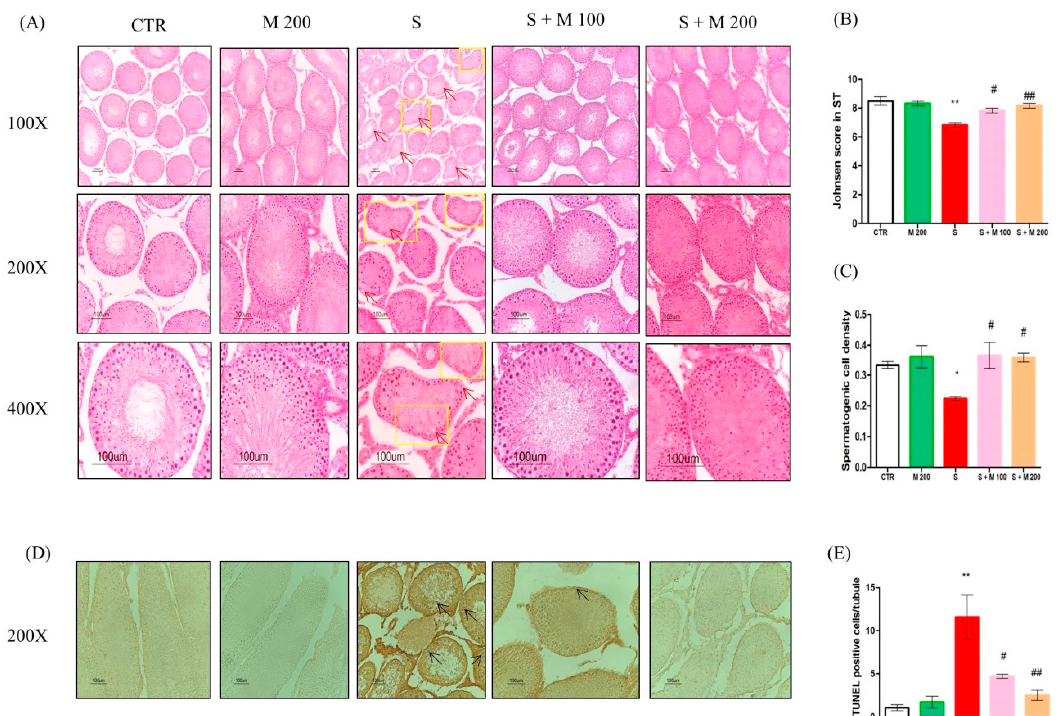
Figure 2. E ff ect of MOTILIPERM on testicular histopathology and germ cell apoptosis based on hematoxylin and eosin (H&E) staining and terminal deoxynucleotidyl transferase-mediated dUTP nick-end labeling (TUNEL) staining of immobilization stress-treated male SD rats. ( A ) Rat testis cross sections stained with H&E showing degenerating round spermatids, spermatocytes, an absence of spermatozoa, irregular seminiferous tubules, and seminiferous tubules with vacuoles in the S group (arrowhead; a). ( B ) Johnsen’s score in seminiferous tubules. ( C ) Spermatogenic cell density in seminiferous tubules. ( D ) Cross section of TUNEL-stained testis showing TUNEL-positive cells (arrows; d). ( E ) Quantification of TUNEL-positive cells expressed as total positive cells / seminiferous tubule. Data are presented as mean ± SEM. The di ff erences were tested by one-way ANOVA followed by Tukey’s post-hoc test; n = 10 for each group. * p < 0.05 and ** p < 0.01 denote significant di ff erence compared to the CTR group; # p < 0.05 and ## p < 0.01 denote significant di ff erence compared to the S group. CTR: control; M 200: MOTILIPERM 200 mg / kg p.o.; S: stress by immobilization group; S + M 100: stress by immobilization + MOTILIPERM 100 mg / kg p.o.; S + M 200: stress by immobilization + MOTILIPERM 200 mg / kg p.o.; p.o.: per oral; ANOVA: analysis of variance; SEM: standard error of the mean.